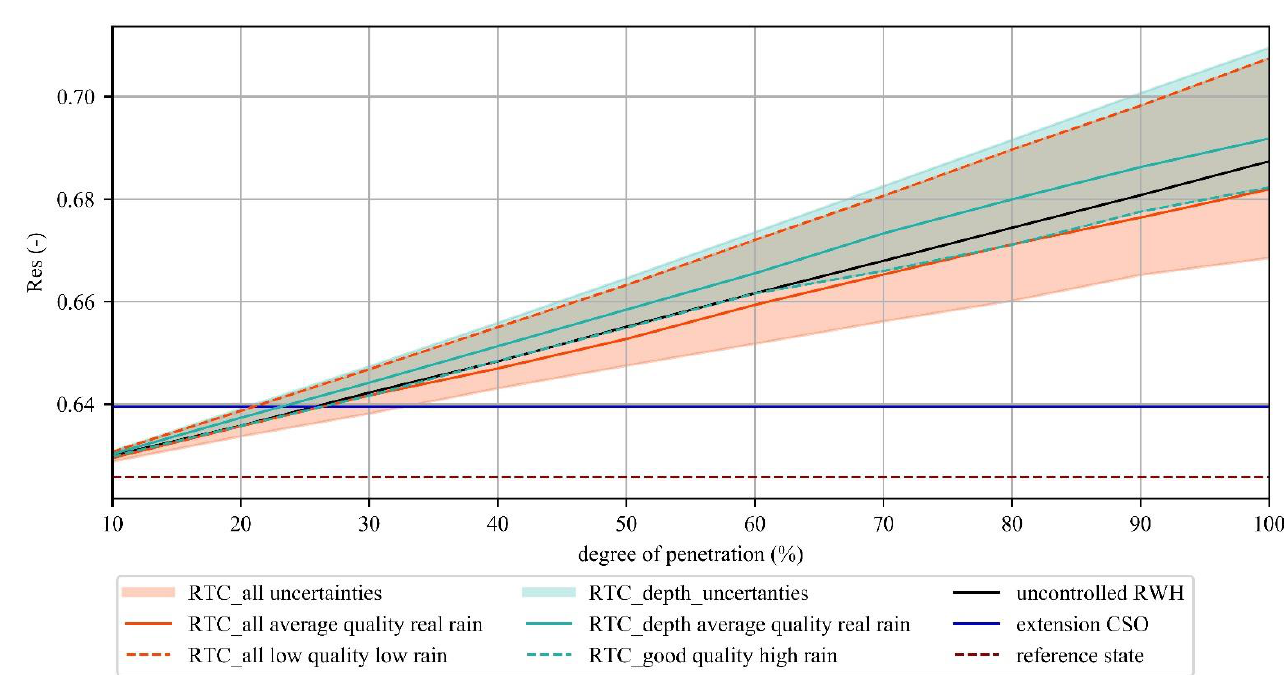
Figure 5. Resilience index (Res) subdivided into control strategies ‘RTC all’ and ‘RTC CSO depth’ and compared with uncontrolled RWH systems for different degrees of penetration. Additionally, a range of digital uncertainties associated with smart RWH systems is highlighted.